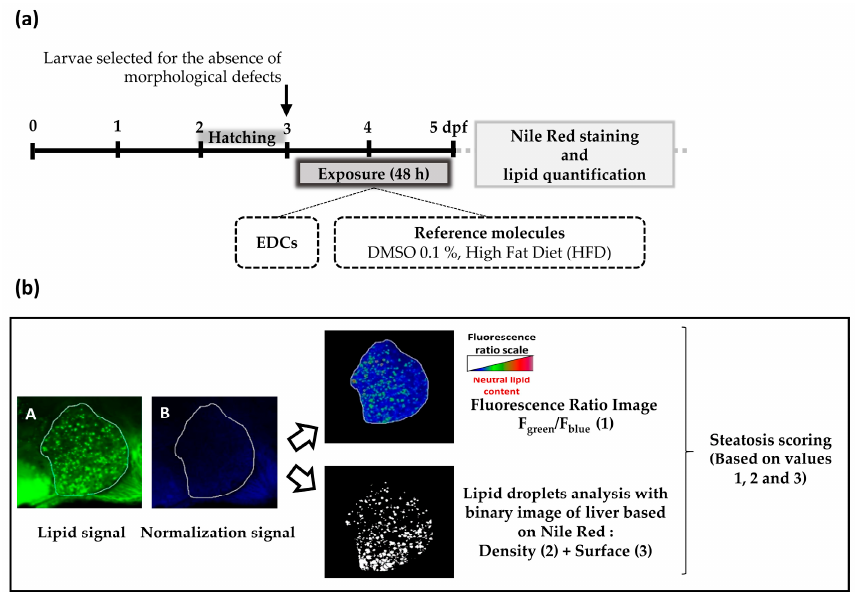
Figure 1. Experimental design of the StAZ bioassay ( a ) Steatogenic Assay on Zebrafish (StAZ) protocol. Zebrafish larvae at 3 days post-fertilization (dpf) were exposed to the selected compounds at non-toxic concentrations, to the positive control (HFD), or to vehicle alone (DMSO 0.1%), during 48 h. Following exposure, larvae were euthanized and fixed, and hepatic lipid accumulation was measured using Nile red staining and fluorescence signal quantification. ( b ) Fluorescent signal quantification workflow. After image acquisition of stained zebrafish larvae with confocal fluorescence microscopy, two types of images were obtained: a first one with a green signal—characteristic of neutral lipid fluorescence, and a second one with a blue signal for normalization—insensitive to neutral lipids (images A and B, respectively). Using Fiji imaging processing software and home-made macros, three parameters were calculated: (1) the ratio of fluorescence intensity of image A to image B per liver area (F green/F blue), (2) the amount of lipid droplets per liver area, and (3) the surface occupied by lipid droplets per liver area. Based on these three parameters, a steatosis score was calculated. Each parameter was pondered by a specific coefficient determined